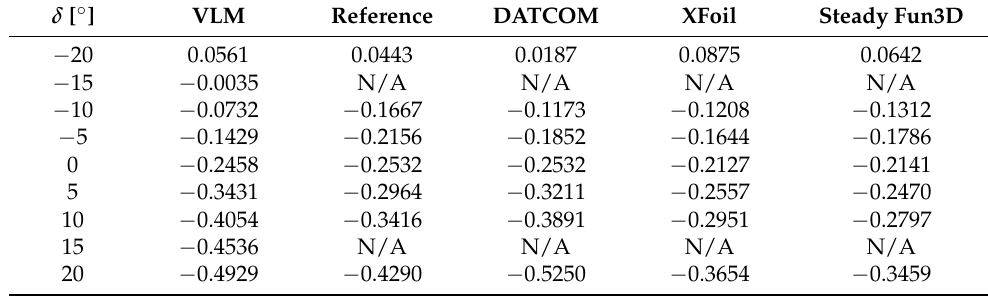
Table A4. Comparison of C h for GA(W)-1 at alpha 12 ◦ .